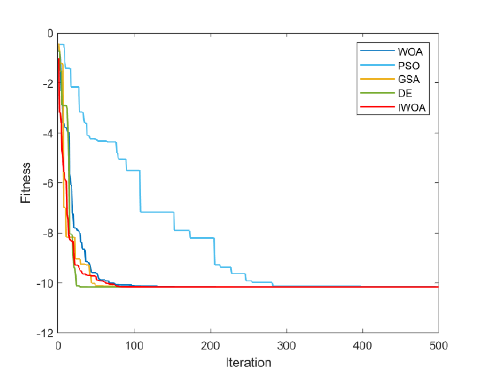
Figure 20. F15. Figure 20. F15.